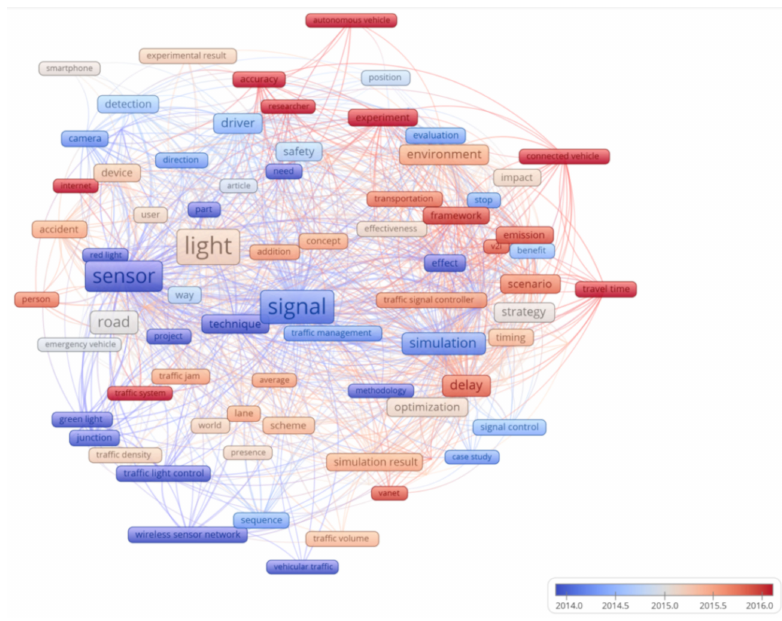
Figure 9. Trending topics (in red) versus old topics (in